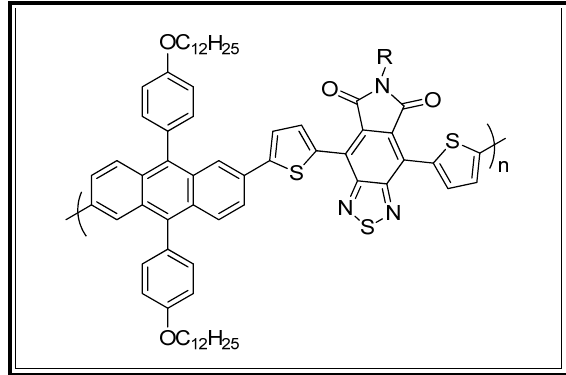
Figure 26. Molecular structures of PPADTBTDI-DMO and PPADTBTDI-8.